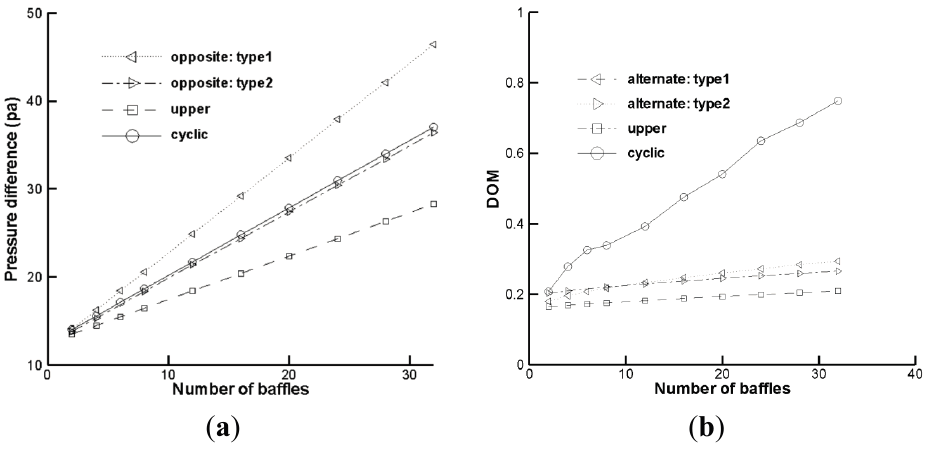
Figure 4. Variation of pressure difference and its relationship with the DOM. ( a ) Pressure difference vs. number of baffles. ( b ) DOM vs. number of baffles.